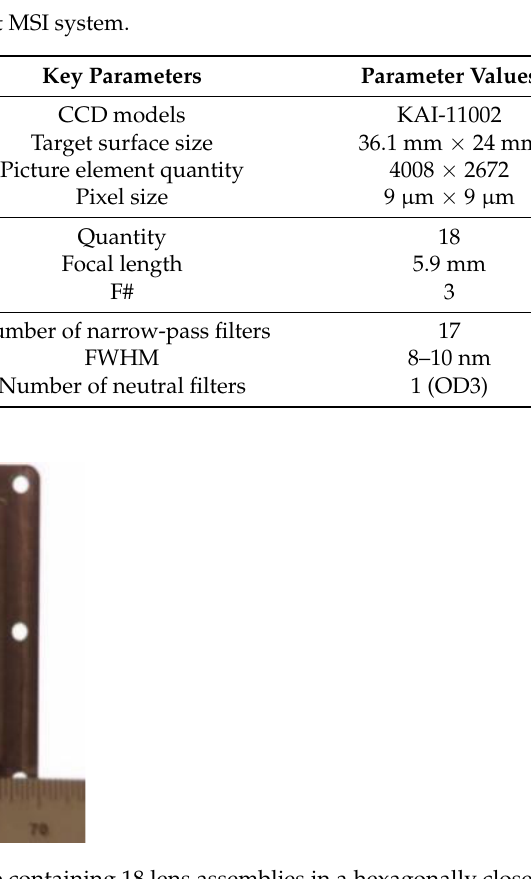
Figure 25. The complete multispectral camera, including the objective assembly and integrated ring illuminator. Figure 26. Target images taken using different cameras. ( a ) A complete image of a target obtained using a multispectral camera. ( b ) An image of the object taken using a conventional camera. 3.1.5. Application of Compound Eye Multispectral Endoscopy Based on TOMBO In the year 2006, Yamada et al. from the Hiroshima Institute of Technology in Japan first conducted a preliminary experimental verification of TOMBO for 3D endoscopy technology [45]. In the year 2011, Kagawa et al. from Shizuoka University in Japan applied TOMBO compound eye MSI technology to a 3D multifunctional compound eye endoscopic system, and combined it with wavefront coding technology, developing a principal prototype of the TOMBO endoscope based on a 3 × 2 aspheric lens array. The prototype presented in Figure 27a,b shows the image captured when observing the interior of a pipe with texture and a diameter of 20 mm. The main parameters are presented in Table 5 [20,46].